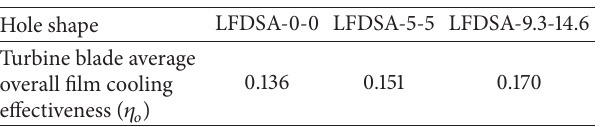
Table 3: Comparison of turbine blade film cooling effectiveness for different hole